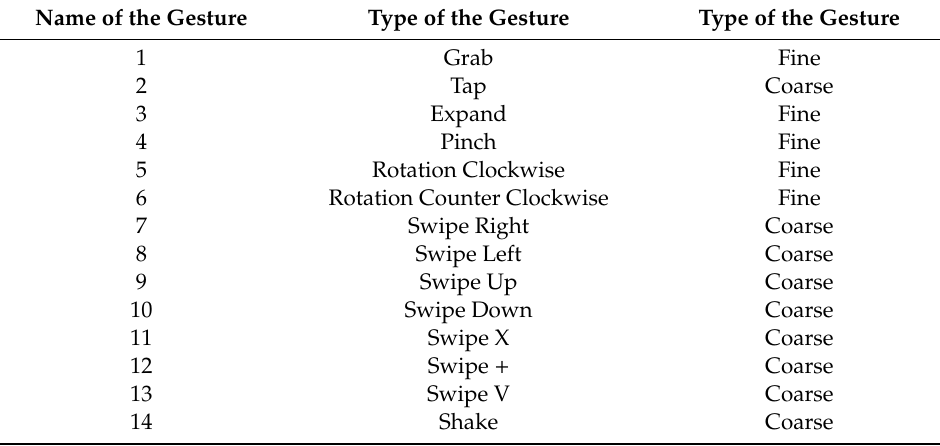
Table 1. List of 14 gestures in the dynamic hand gesture database (DHGD).